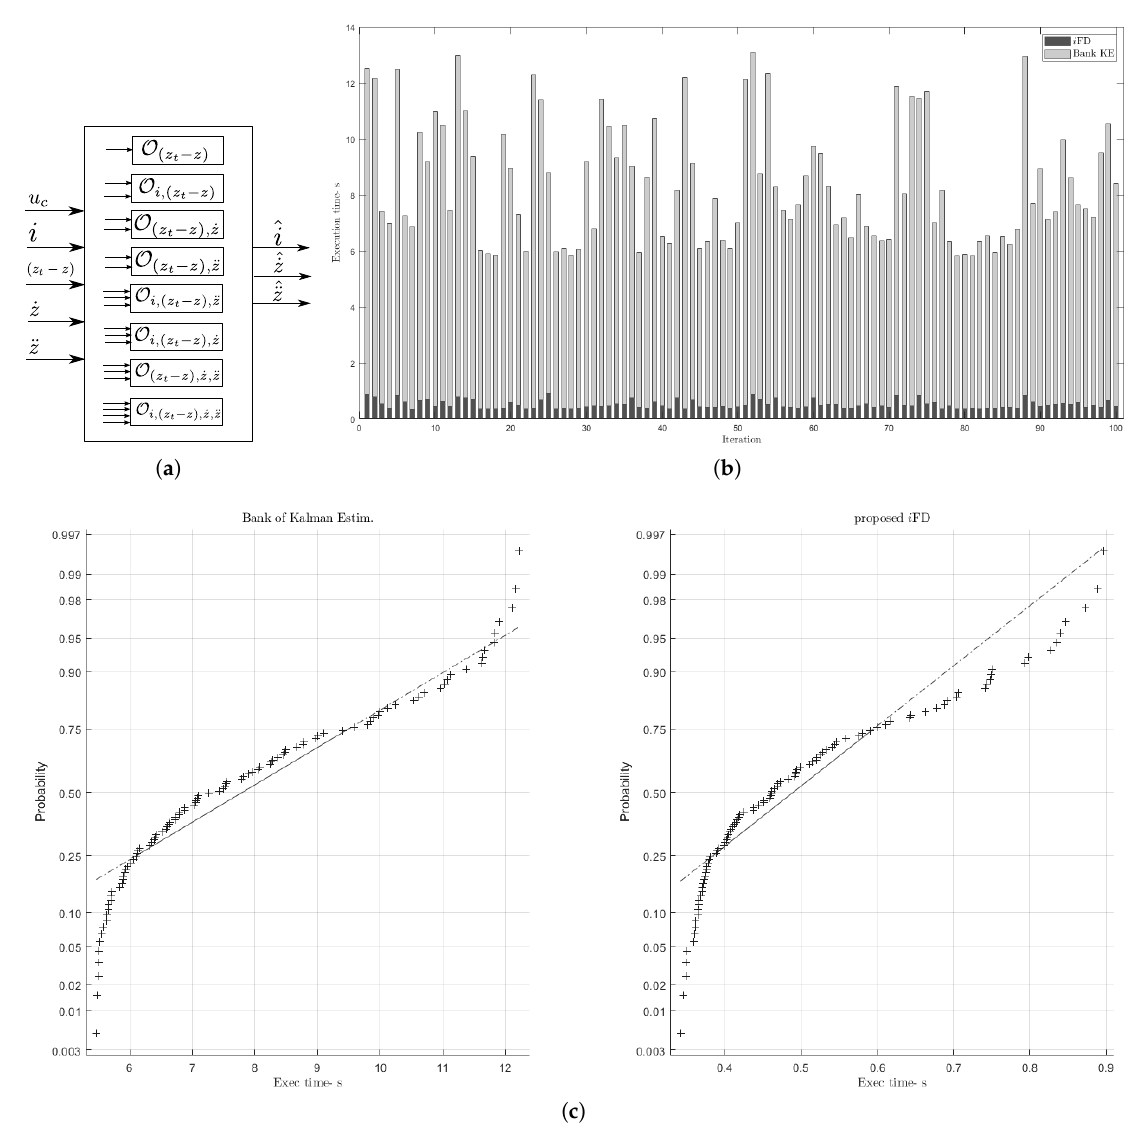
Figure 10. Computational complexity comparison bank of KE vs. i FD (AI-based) for multiple sensors failure detection on the EMS system: ( a ) bank of KE (inner box) vs. i FD architecture (outer box), ( b ) execution time performance, ( c ) normal probability plot of execution time